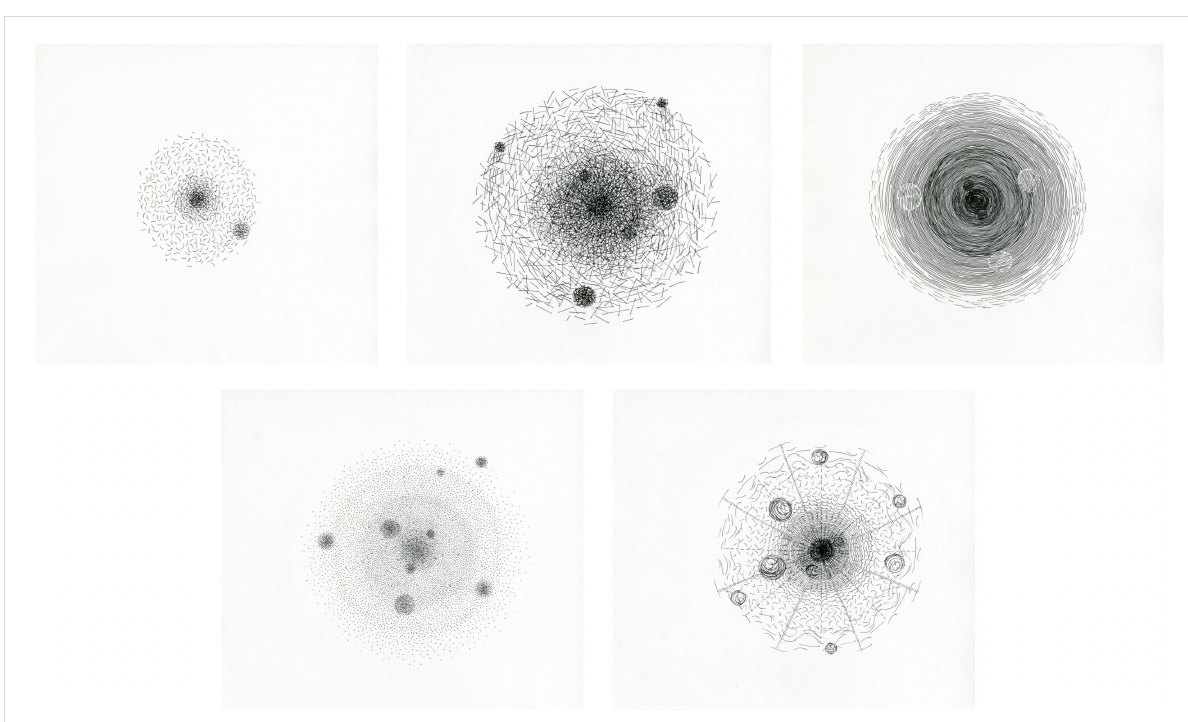
Figure 5: Artistic interpretation by Jette Flügge of the atoms hydrogen, carbon, nitrogen, oxygen, and fluorine (from top left to bottom right).